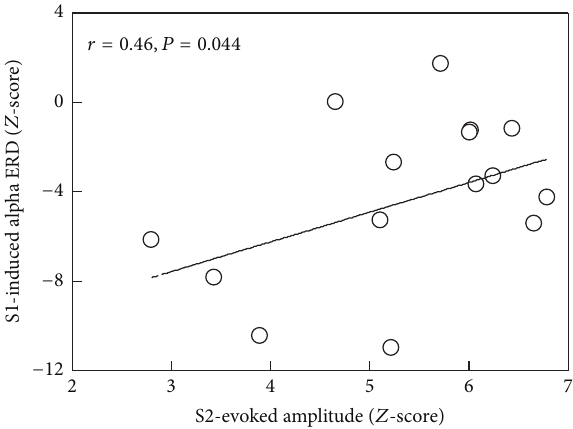
Figure 5: Association between stimulus 1- (S1-) induced alpha ERD and stimulus 2- (S2-) evoked response in the SIIc among the elderly